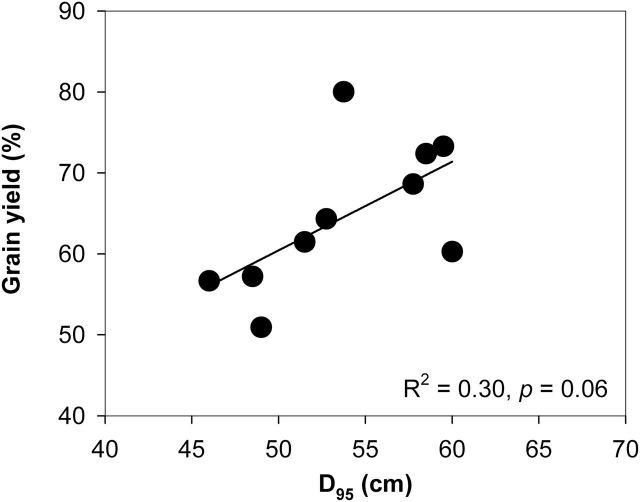
Correlation of grain yield (% of grain yield under high N) with D95 in the field in RS at anthesis. Each point is the mean of four replicates of each genotype.